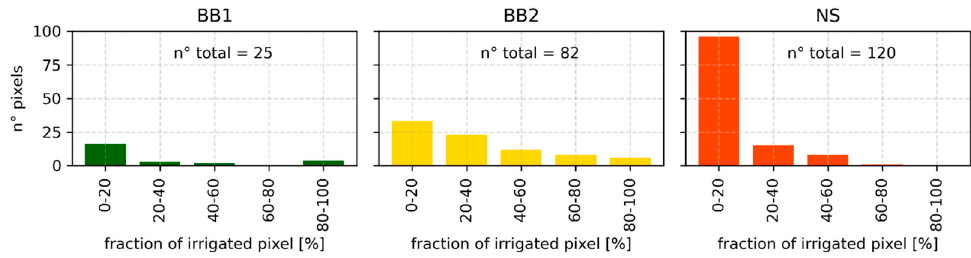
Figure 2. Number of S1-SSM pixels covering the reference irrigated fields, grouped by the pixel fractional irrigated area, i.e., the ratio between the irrigated area covered by a S1-SSM pixel and the pixel area.